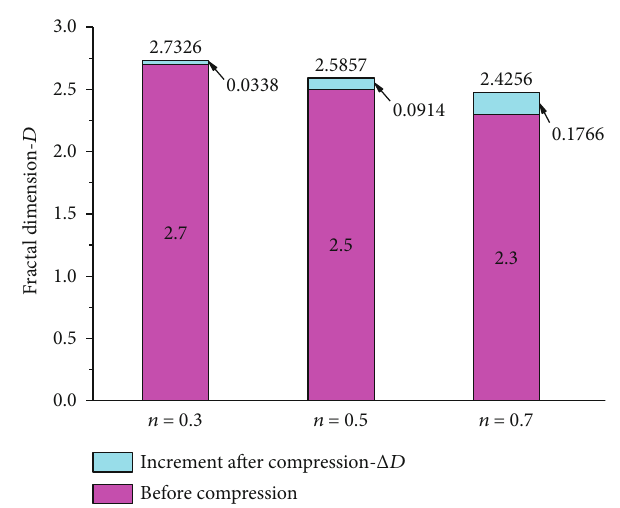
Figure 11: Change in fractal dimensions of the crushed sandstone samples of di ff erent grain compositions before and after compression (axial stress of